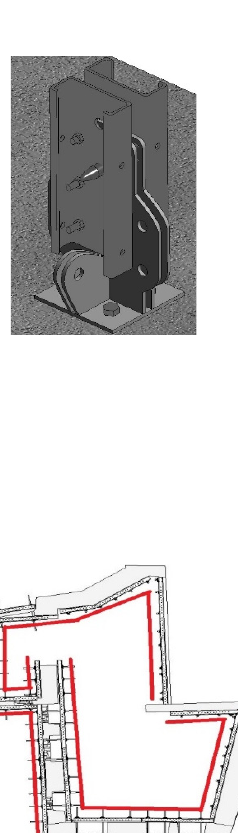
Figure 9. Components based in a face-based template.